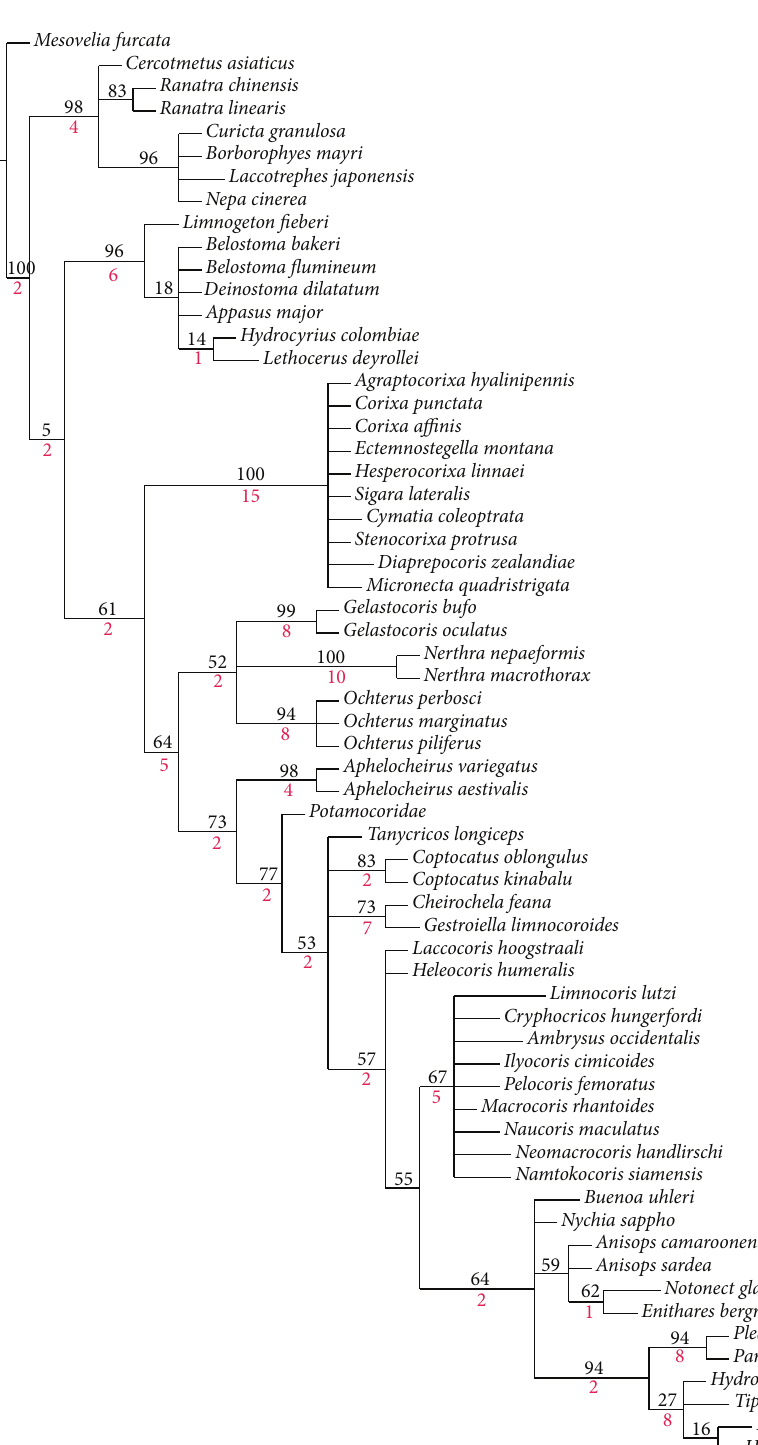
Figure 7: Bootstrap support; a consensus tree based on 1000 replicate samples of the character dataset, showing the bootstrap support for clades. L = 212, Ci = 62, Ri = 77. Bremer support values are marked with the red